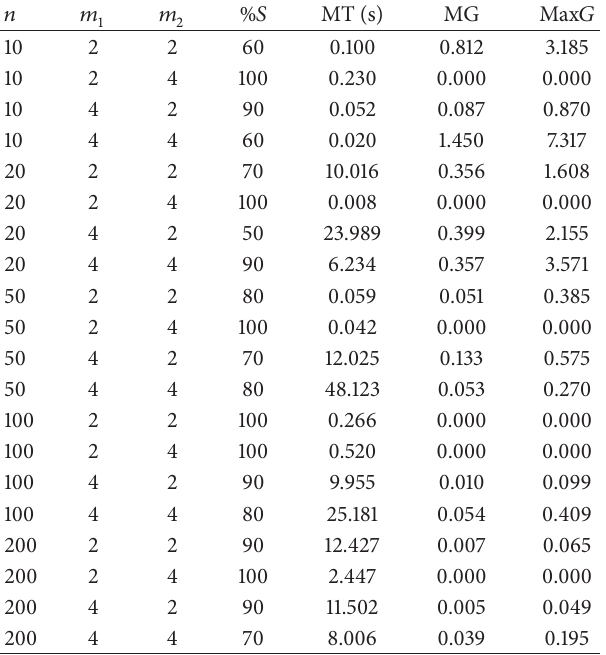
Table 3: Performance for 𝑎 = 𝑐 = 𝑑 = 20 and 𝑏 = 40 .